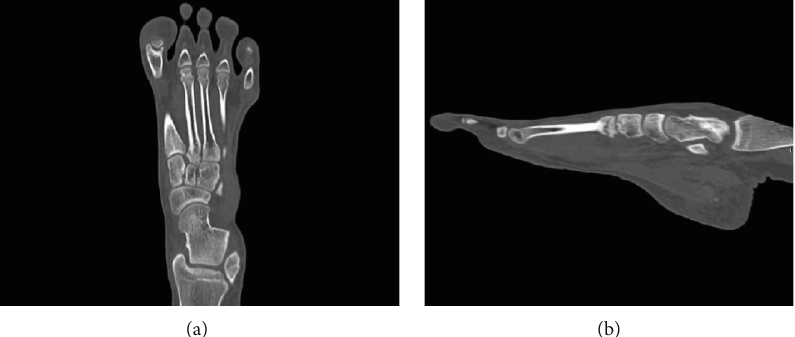
Figure 2: Preoperative CT demonstrated a fracture line at the base of the second metatarsal and sclerotic change around the fracture site on (a) coronal and (b) sagittal